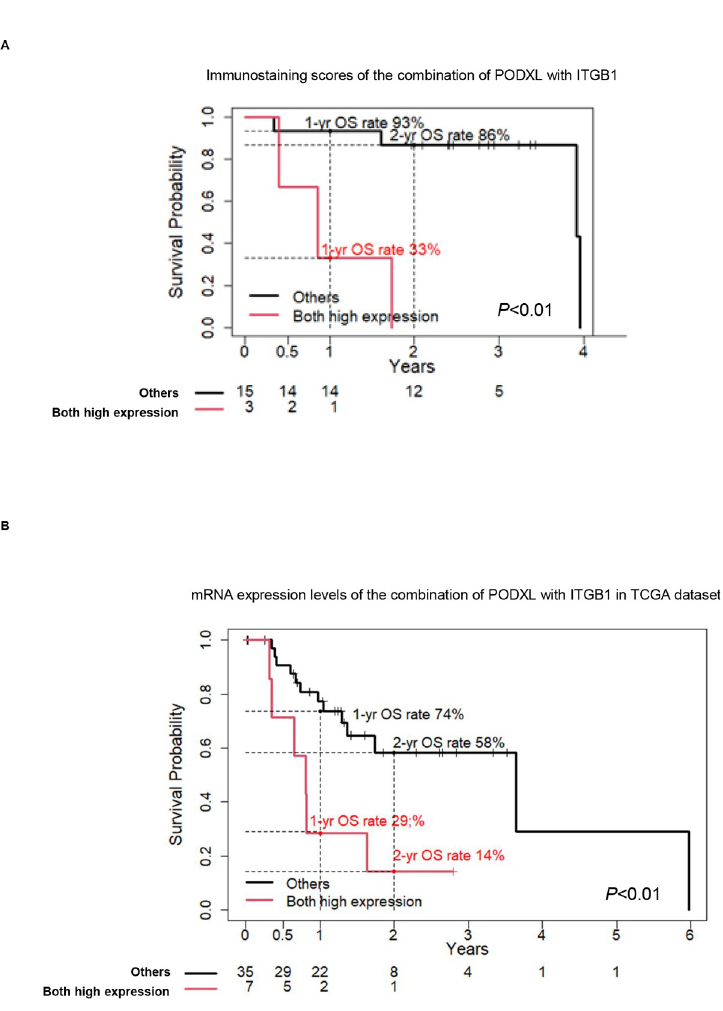
Fig 6. Correlation between the combination of PODXL with ITGB1 and poor outcomes of PDAC patients at stage IA-IIA. (A) Kaplan-Meier analysis of OS rate according to the immunohistochemical scores of the combination of PODXL with ITGB1 in PDAC patients at stage IA-IIA. (B) Kaplan-Meier analysis of OS rate according to the mRNA expression levels of the combination of PODXL with ITGB1 in the TCGA set. including both resectable and borderline PDAC before surgery. Based on Kaplan-Meier curves, the postoperative OS rate for UICC TNM stage IA-IIA PDAC patients with high expression of both PODXL and ITGB1 (n = 3) in EUS-FNAB samples before surgery was sig- nificantly shorter than that of UICC TNM stage IA-IIA PDAC patients without high expres- sion of both PODXL and ITGB1 (n = 15) ( P < 0.01) (Fig 6A). The 1-year and 2-year OS rates of UICC TNM stage IA-IIA patients highly expressing both PODXL and ITGB1 compared with other PDAC patients were 0.33 (95% CI: 0.06–1.00) and 0.93 (95% CI: 0.81–1.00), and 0.00 and 0.86 (95% CI: 0.71–1), respectively (Table 4). The prognostic analysis using messenger RNA (mRNA)-seq data of 42 resected UICC TNM stage IA-IIA PDAC samples from The Can- cer Genome Atlas (TCGA) database revealed that the postoperative OS rate for PDAC patients with UICC TNM stage IA-IIA with upregulated mRNA levels of both PODXL and ITGB1 (n = 7) was significantly lower than that for PDAC patients without high expression of both PODXL and ITGB1 (n = 35) ( P = 0.006) (Fig 6B). This suggests that the combination of